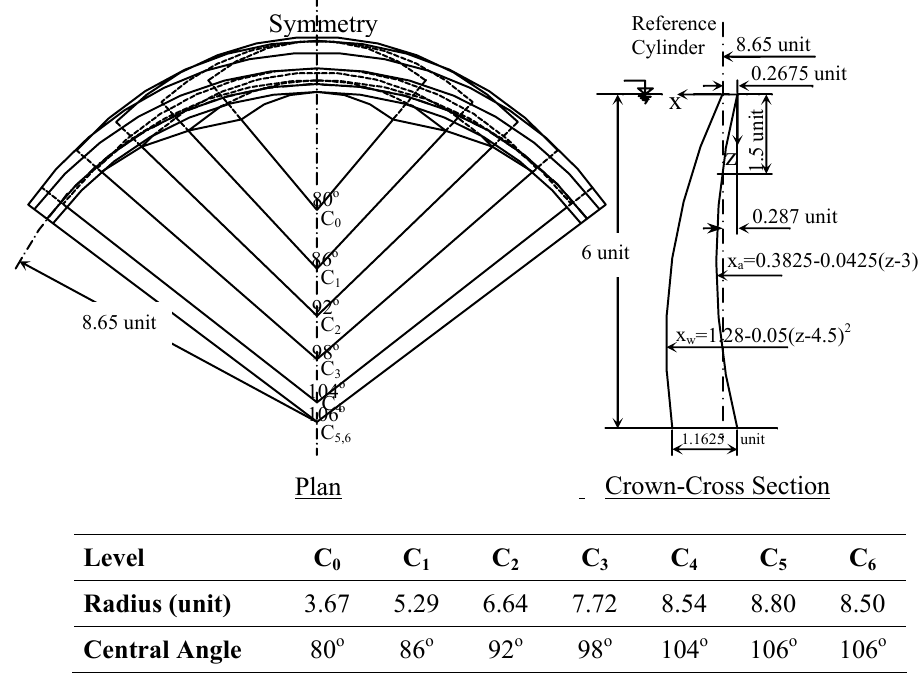
Fig. 2. The view in plan and vertical crown cross section of Type-5 arch dam.